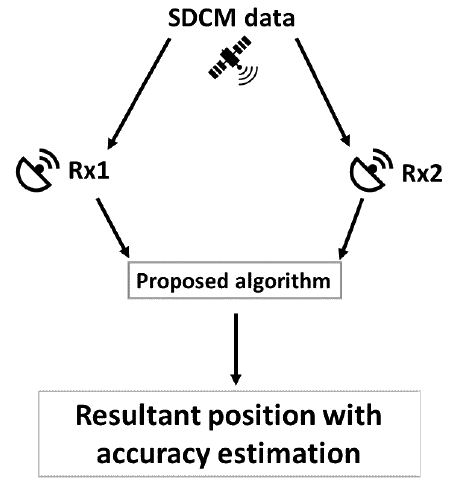
Figure 1. The flowchart of presented mathematical algorithm.